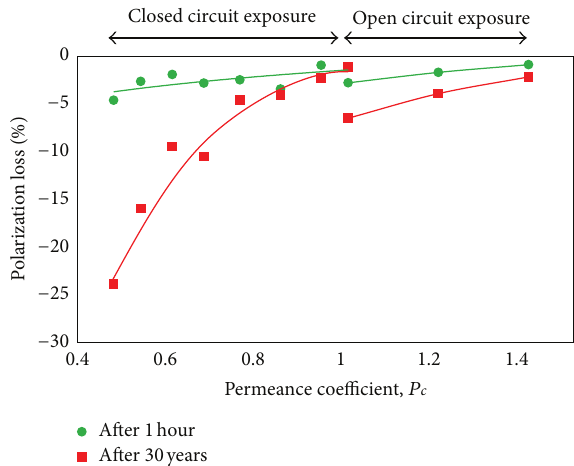
Figure 10: Estimated polarization losses as a function of 𝑃 𝑐 in closed- and open-circuit exposures in material 2 magnets at 120 ∘